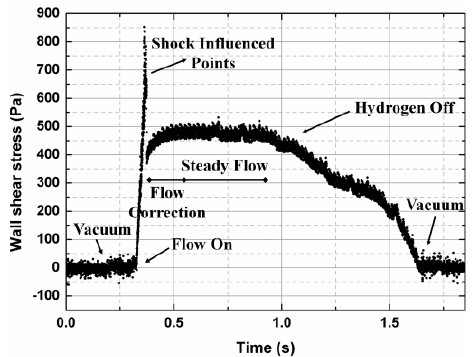
Figure 7. The measured wall shear values by the high-temperature MEMS surface fence located in the downstream of the isolator entrance. downstream of the isolator